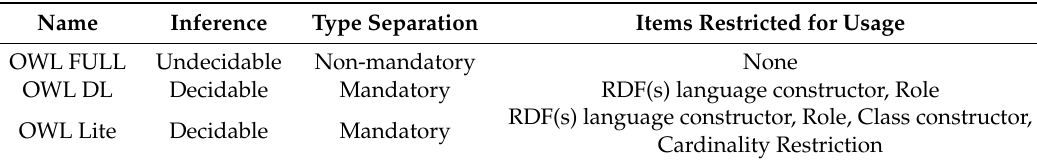
Table 1. Differences among OWL